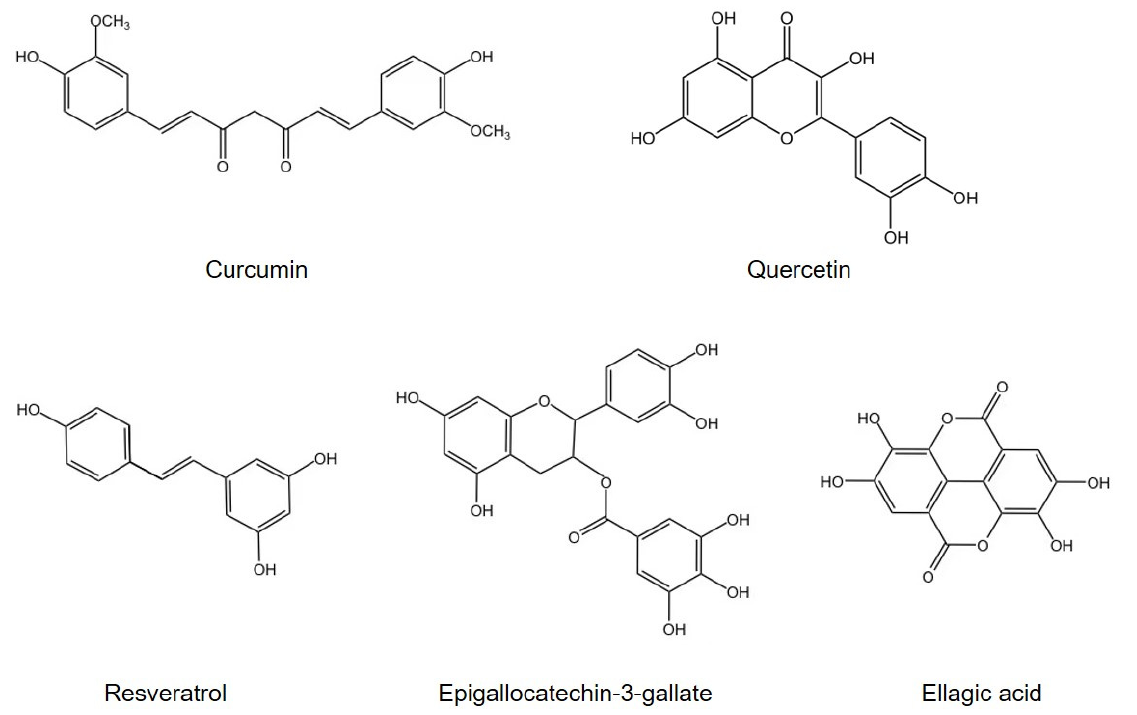
Figure 2 . The structure of polyphenols in this review (curcumin, quercetin, resveratrol, epigallocat- echin-3-gallate, and ellagic acid). This figure was created with